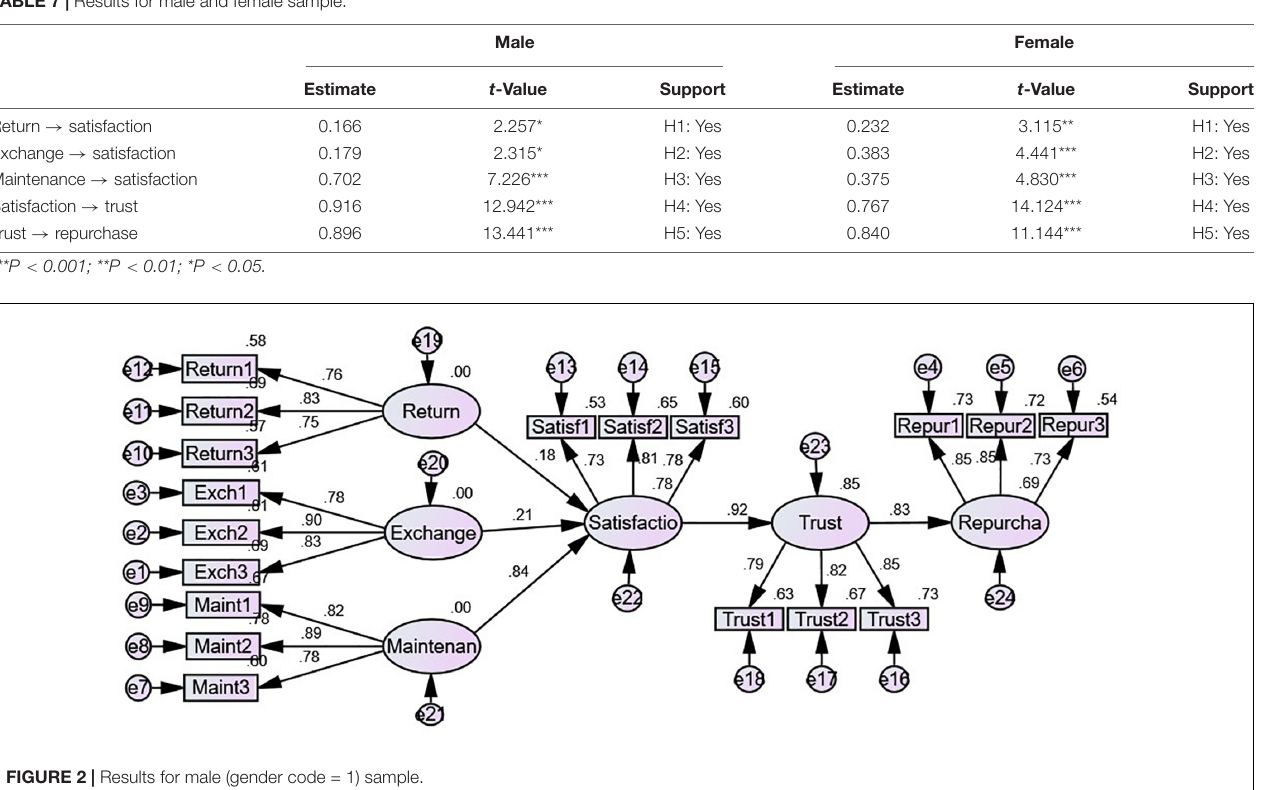
FIGURE 2 | Results for male (gender code = 1)